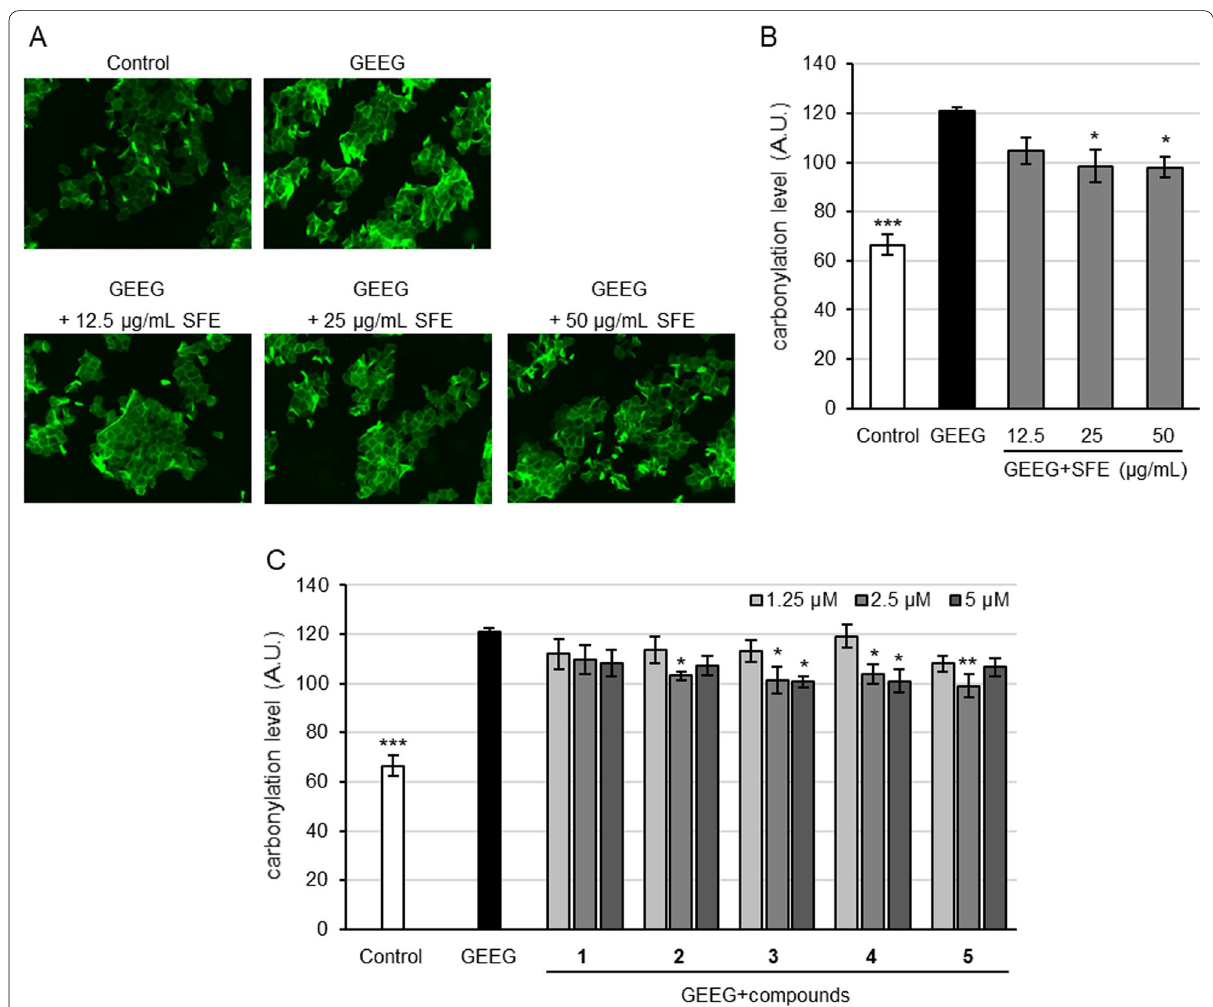
Fig. 3 Inhibitory activity of SFE and compounds 1 – 5 against GEEG‑induced protein carbonylation in SC. Tape‑stripped SC was treated with SFE or components for 16 h at 37 °C. SC was stored in the absence or presence of GEEG for 24 h at 22 °C. Protein carbonylation in SC were detected by 5‑FTSC. Inhibitory activity of SFE ( A , B ) and compounds 1 – 5 ( C ) against GEEG‑induced protein carbonylation in SC and typical fluorescence image of protein carbonylation ( A ). Bars in B and C represent mean S.E., n 3; * p < 0.05, ** p < 0.01, *** p < 0.001 vs. GEEG‑treated ± =